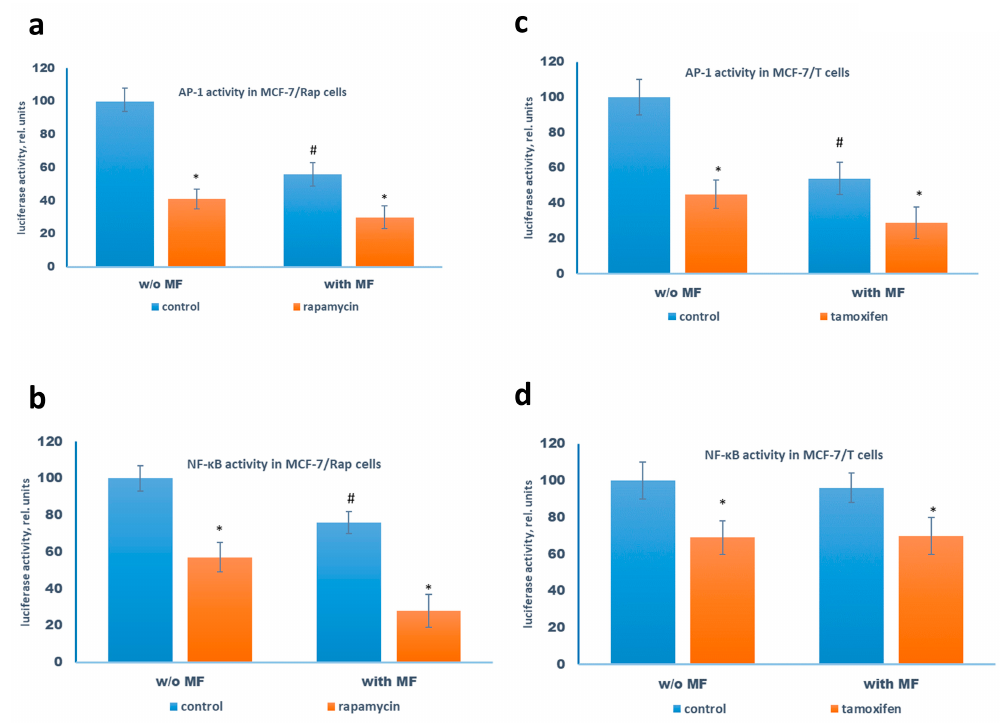
Figure 4. Reporter analysis of the transcriptional activity of AP-1 and NF- κ B in the MCF-7 / Rap and MCF-7 / T cells. The MCF-7 / Rap ( a , b ) and MCF-7 / T ( c , d ) cells were pretreated with or without 2 mM metformin for 2 days, then the cells were transfected with the AP-1 ( a,c ) or NF- κ B ( b,d ) plasmid containing the luciferase reporter gene under the AP-1 or NF- κ B-responsive elements, respectively, and β -galactosidase plasmid. Three hours after transfection the cells were treated with 2 mM metformin (MF) and 1 µ M rapamycin ( a,b ) or 2 mM metformin and 5 µ M tamoxifen ( c,d ) for 24 h. The luciferase and β -galactosidase activities were determined as described in Materials and Methods. p < 0.05: * versus respective control, # versus control cells w / o metformin. Data represent the mean value ± SD of three independent